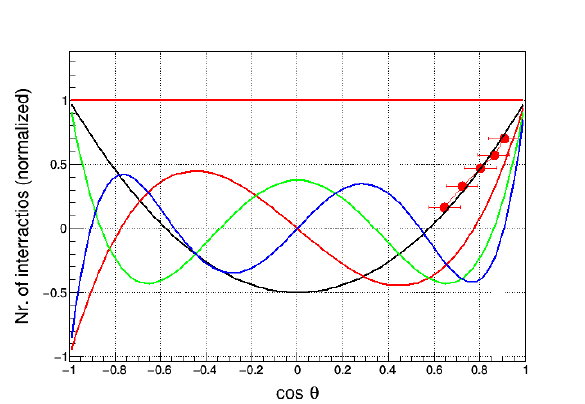
Figure 6. The angular distribution for the 19 F(p, α 0 ) 16 O reaction at 700 keV in the center-of-mass system. The experimental points (with red) are overlapped with scaled Legendre polynomial of orders from one to